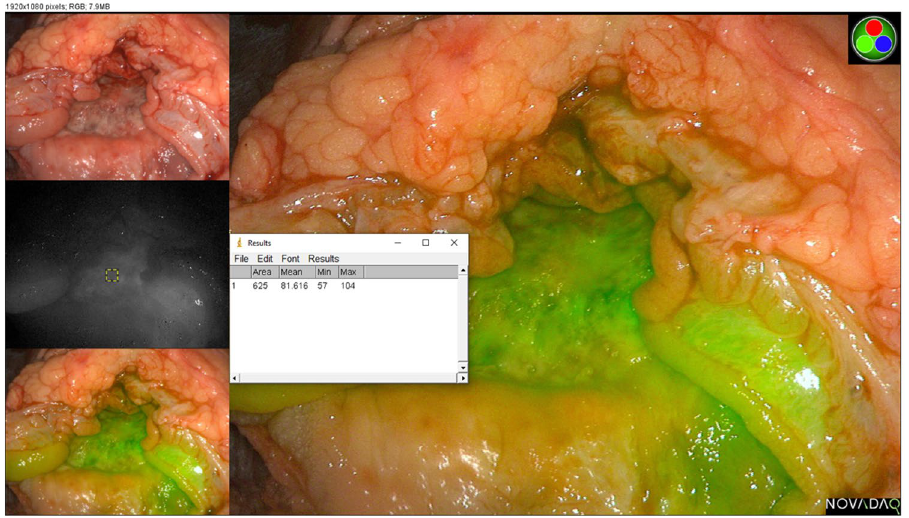
Figure 1. Photograph of mucosal surface of an ex vivo opened, resection specimen in a patient with rectal adenocarcinoma being assessed for tumour static signal intensity using ImageJ. ICG was administered at the time of surgery commencement with the photograph being taken postoperatively using the Pinpoint endoscopic NIR system.